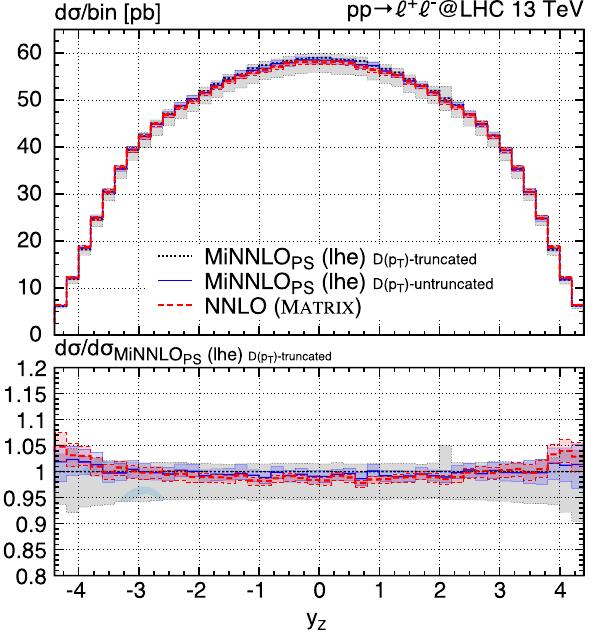
Fig. 1 Rapidity distribution of the Z boson. The plot compares the MiNNLO PS prediction with untruncated (blue solid) and truncated (black dotted) D ( p T ) function at the LHE level with the NNLO predic- tion obtained with Matrix (red, dashed). The lower panel shows the ratio to the truncated